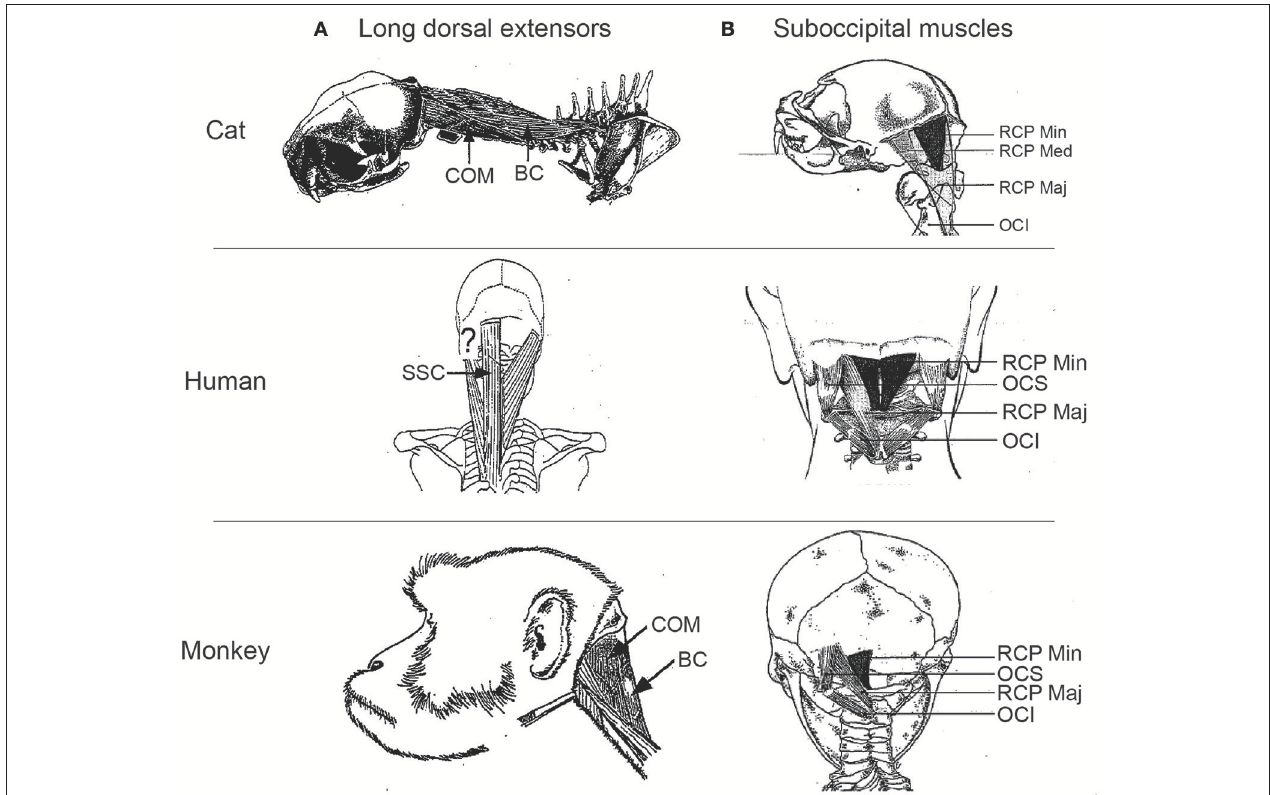
FIGURE 5 | Comparative anatomy of long dorsal extensors (A) and suboccipital muscles (B) in cats, humans, and monkeys. Question mark in (A) shows location of where COM would insert in the human skull, if present. COM, complexus; BC, biventer cervicis; SSC, semispinalis capitis; RCP major, rectus capitis posterior major; RCP min, rectus capitis posterior minor; RCP med, rectus capitis posterior medius; OCI, obliquus capitis inferior; OCS, obliquus capitis